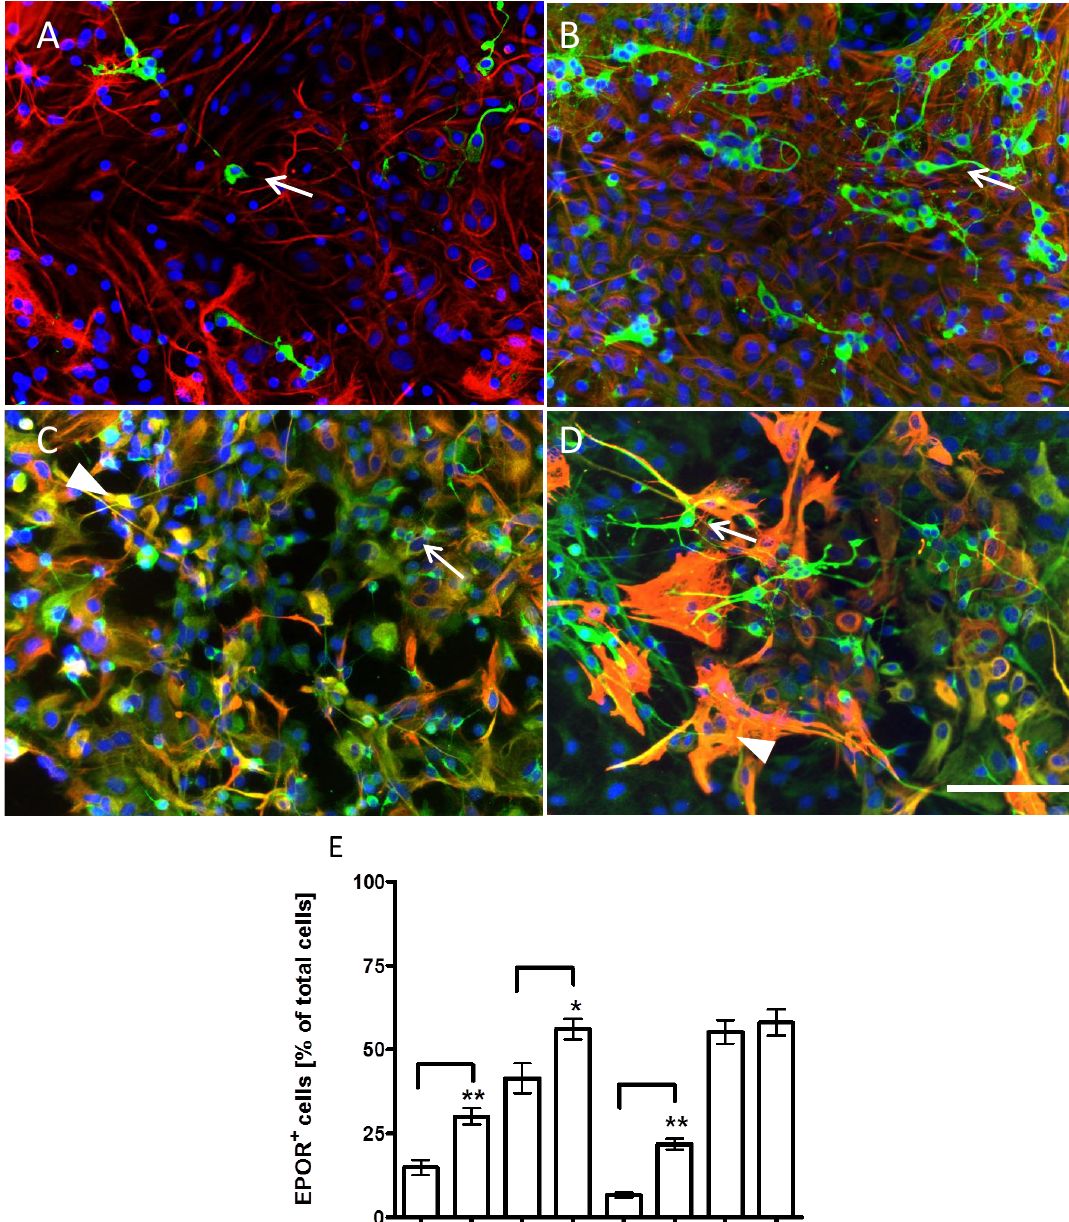
Figure 5. Expression of EPOR (green fluorescence) and GFAP (red fluorescence) in rat astroglial primary culture. Cell nuclei are stained with DAPI (blue). ( A ) Normoxic control (DIV21); ( B ) Cultures treated with BQ123 during normoxic conditions (DIV21); ( C ) Hypoxic control (DIV21); ( D ) Cells treated with BQ123 during hypoxia (DIV21). Arrows indicate the EPOR-positive bona fide neural precursors and neurons negative for GFAP. Arrowheads demonstrate either EPOR−/GFAP+ astrocytes ( A , B ) or those positive for both EPOR and GFAP ( C , D ). Scale bar in A – D 100 µm ; and ( E ) Quantification of EPOR-positive cells in astroglial primary cultures (DIV7 and DIV21) normalized to the mean of the total amount of cells per image ( n = 3) counted by DAPI. p < 0.05 was considered as significant ( * p < 0.05, ** p <